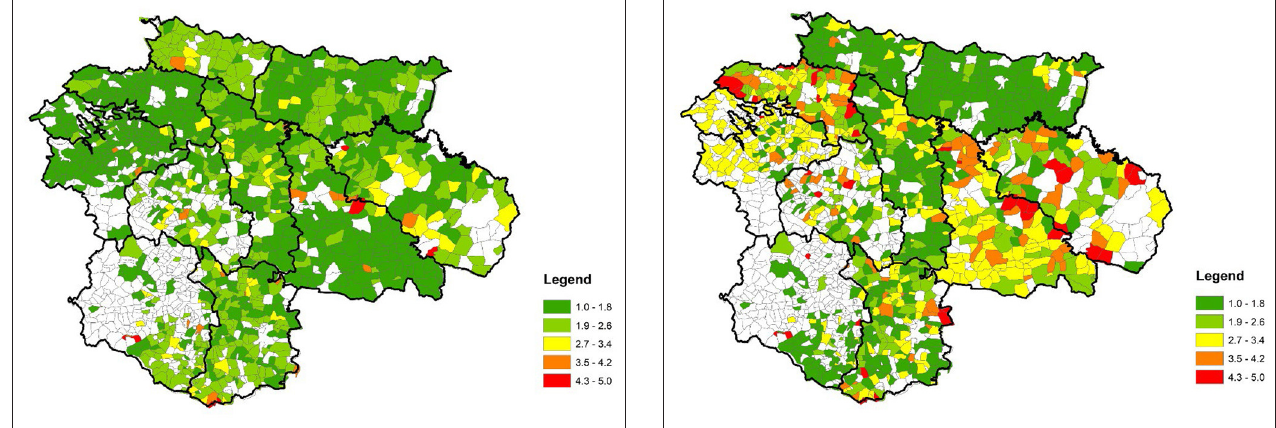
FIGURE 8 | Village capacity criterion. FIGURE 9 | Asset management